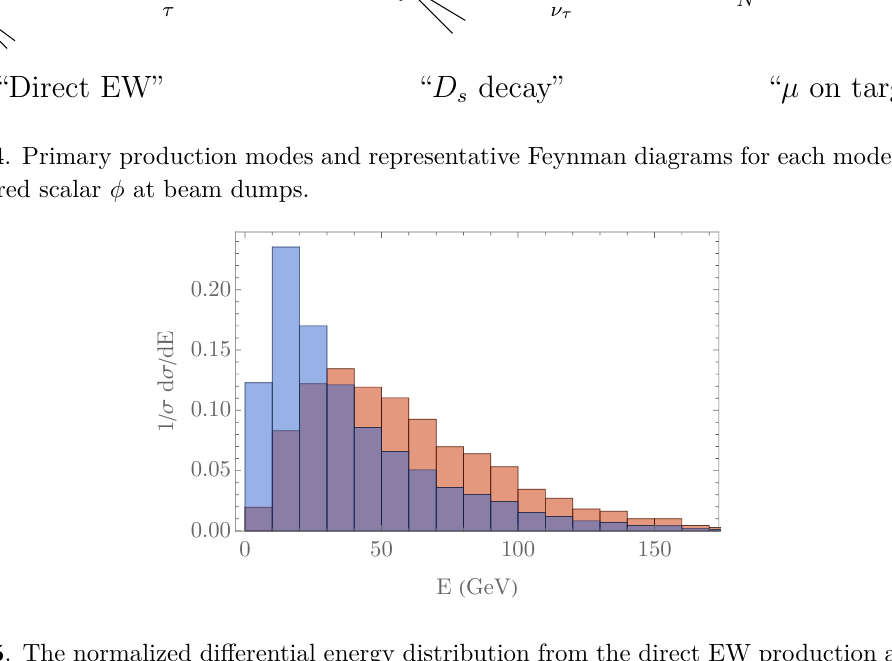
Figure 5 . The normalized differential energy distribution from the direct EW production at SHiP experiment. The blue and red distribution are before and after the angular acceptance